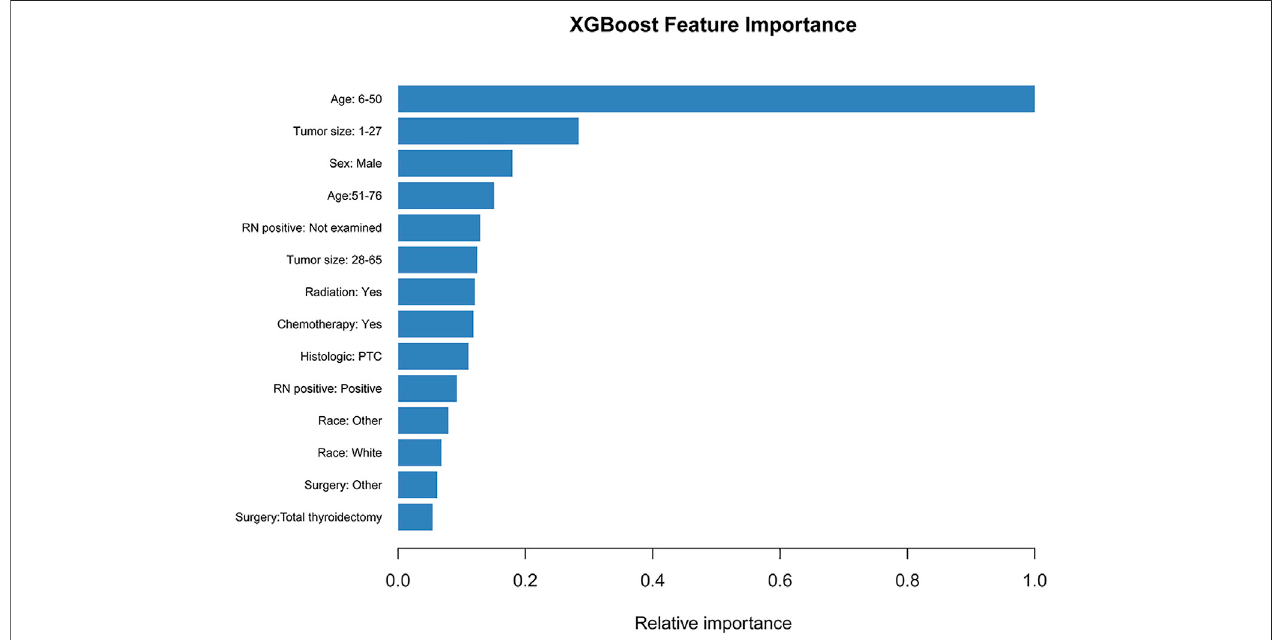
FIGURE 3 | The XGB model was used to calculate the importance of each feature. The bar chart depicts the relative signi fi cance of the variables.